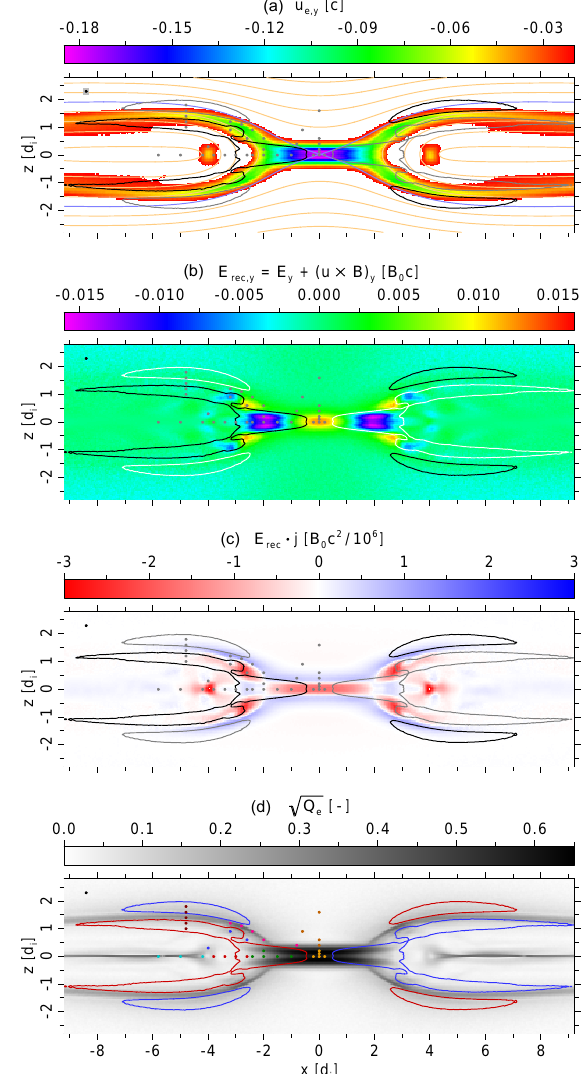
Figure 2. Magnetic reconnection snapshot with indications of the sampling points for the electron velocity distribution functions. The coordinate system is right-handed; Earth is to the right, and y > 0 points towards dusk. Panel (a) visualizes the electron bulk velocity in the out-of-plane component u e ,y (color-coded). The gray square indicates the size of the analysis area around the analysis posi- tions (dots). Overplotted orange lines follow the in-plane magnetic field, while the field line crossing the reconnection center is blue. The contour lines indicate a speed of u e ,x = ± 0 . 04 c in all panels, where black or red represents a leftwards flow and white or blue a rightwards flow. In panel (b) we show the out-of-plane component of the reconnection electric field E rec = E + u × B (color-coded). Panel (c) contains the scalar product of the reconnection electric field and the current density E rec · j (coded in red, white, and blue). Panel (d) displays the square root of the non-gyrotropy index (linear grayscale). The color code of the dots indicates the grouping of analysis